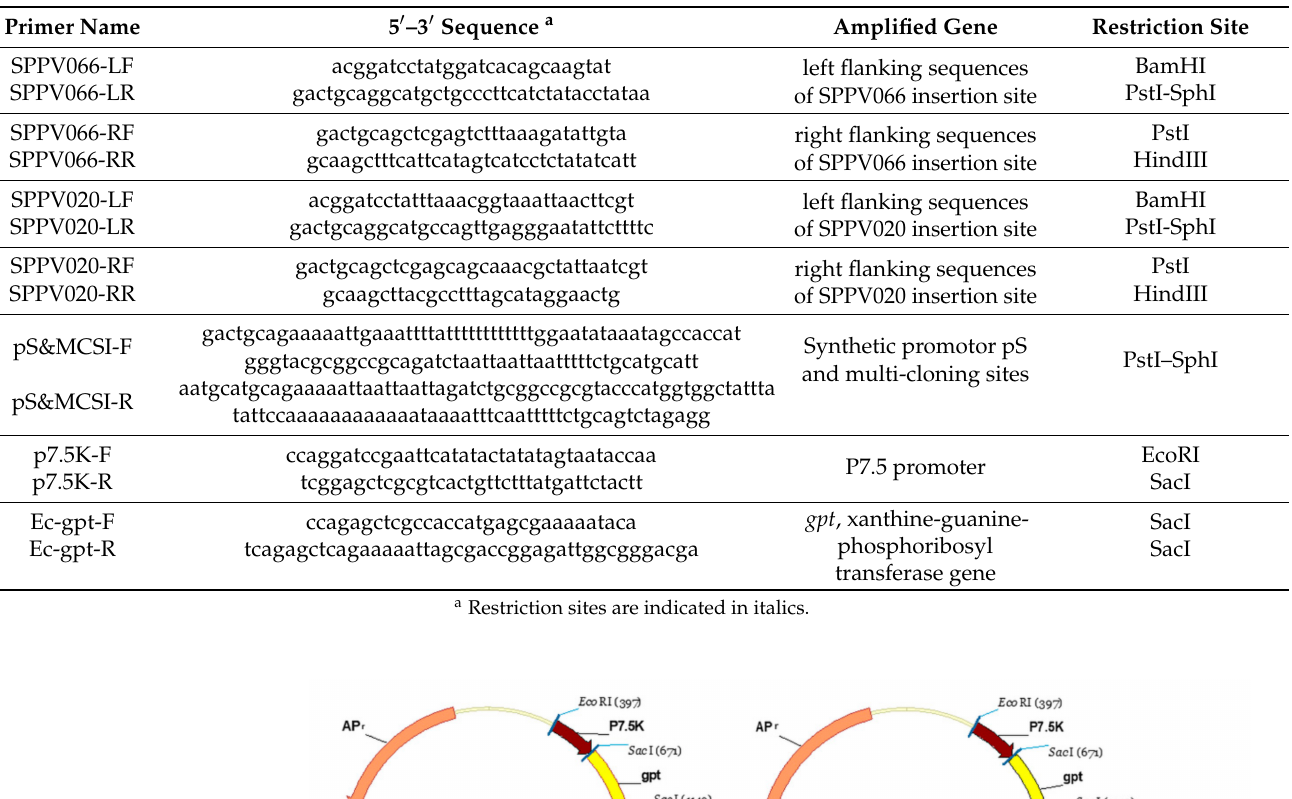
Table 1. Primers utilized for integration plasmids’ construction.